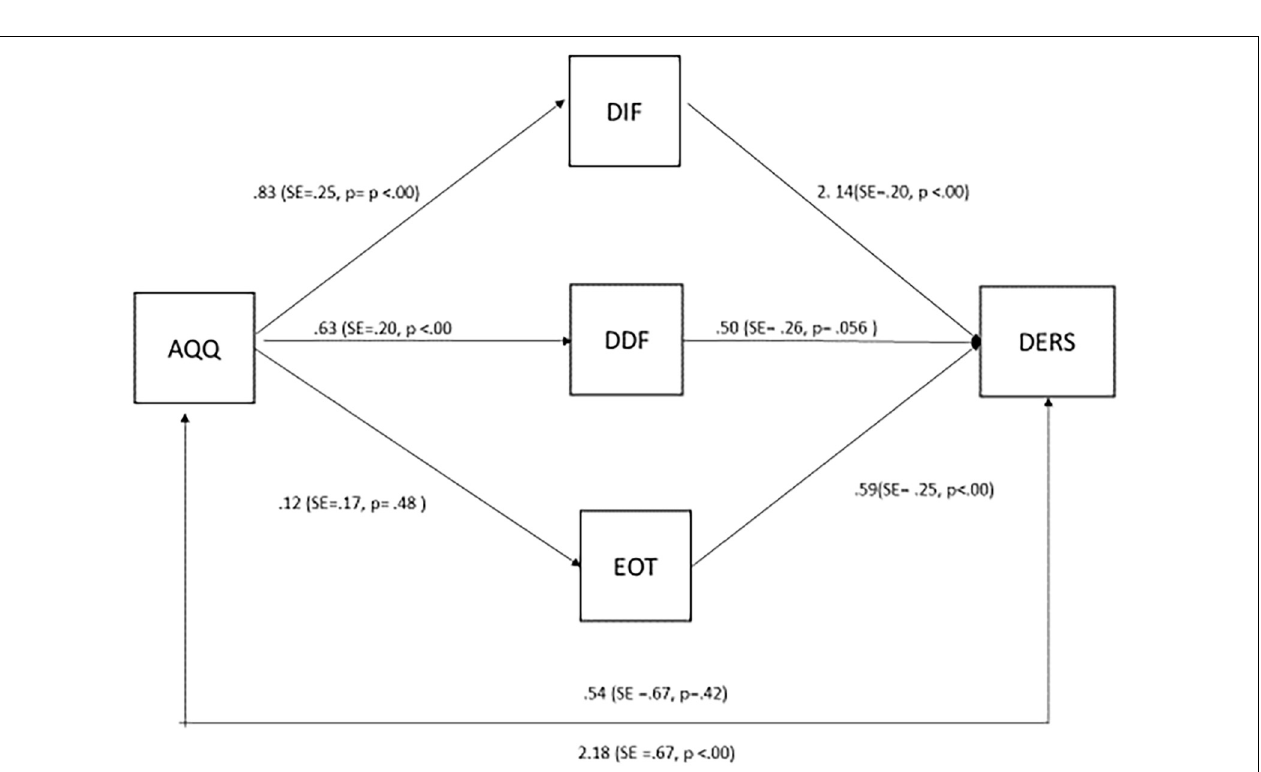
FIGURE 3 | Structural equation model